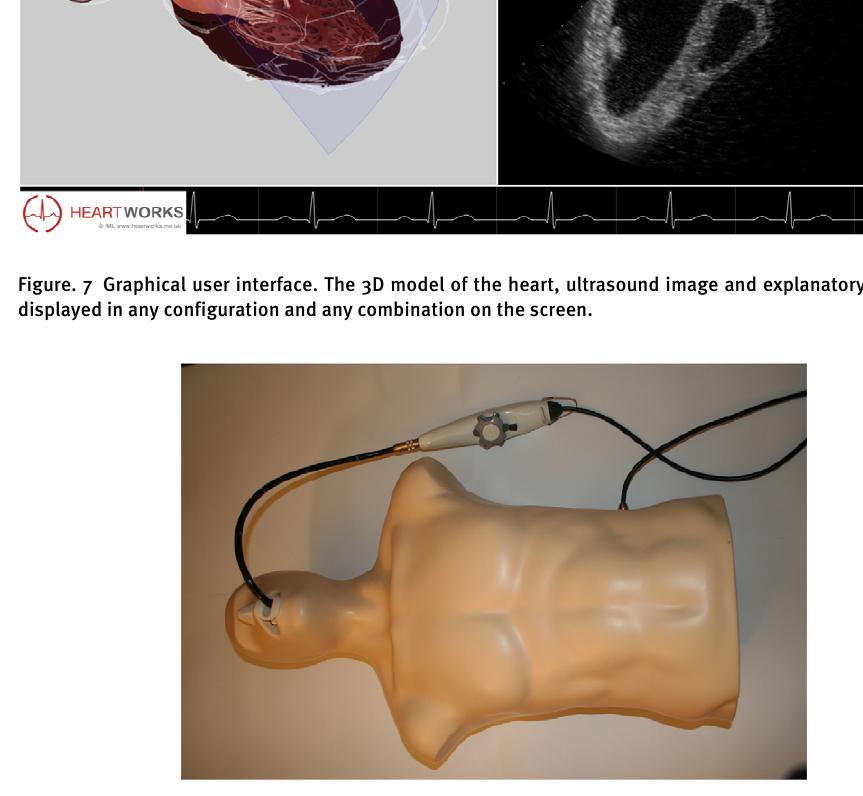
Figure. 8 Simulator mannequin and